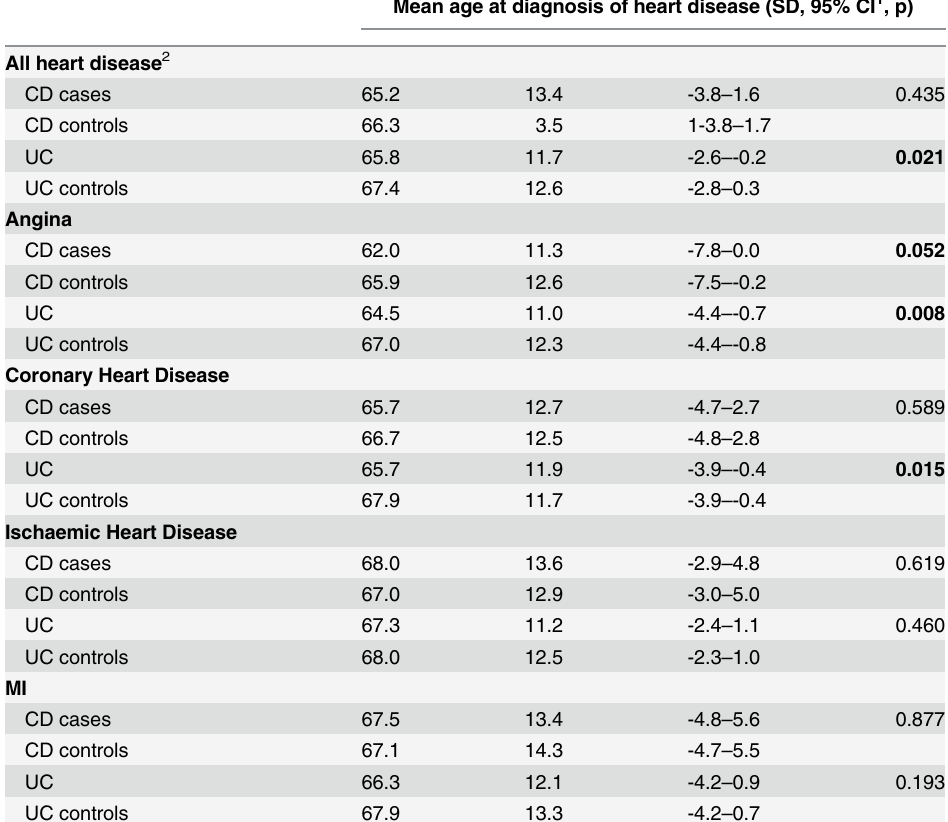
Table 2. Mean age at diagnosis of ischaemic heart disease comparing patients with and without IBD (COHORT A) *